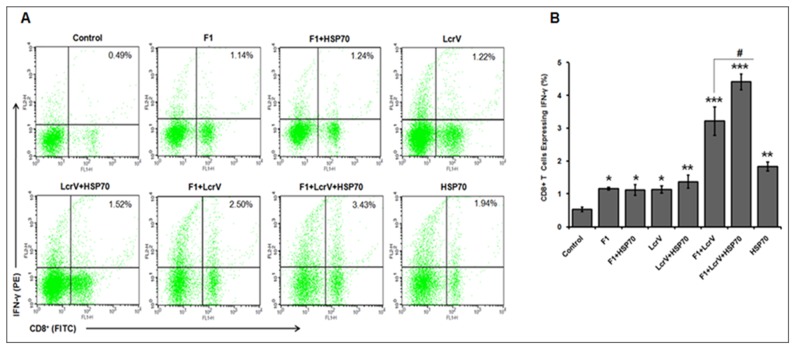
Flow cytometric analysis showing the percentage of IFN-γ producing CD8+ T cells in the spleens of immunized Balb/C mice following in vitro stimulation with specific antigens as indicated and anti-CD28 [A].Graphical representation showing the significant difference in the percentage of IFN-γ producing CD8+ T cells in the spleen of different immunized animal groups after stimulation with specific antigens in comparison to the PBS control group. Each bar represents the average of 3 mice/group ± S.D [B]. Analysis was done by one way ANOVA, All Pairwise Multiple Comparison Procedure (Fisher LSD Method). *P<0.05; **P<0.01; ***P<0.001; #P<0.001.